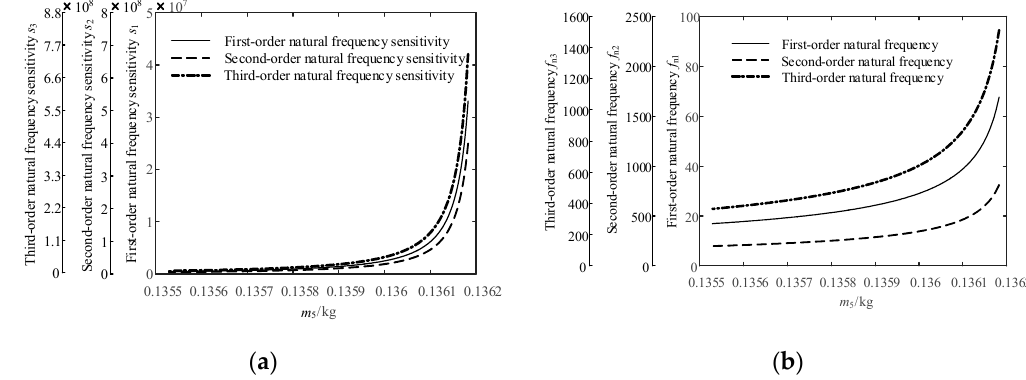
Figure 10. The variation law of the first three natural frequencies and their sensitivities of the jet system under a different initial gas content of fluid with the mass of fluid unit 2. ( a ) Variation law of natural frequency sensitivity. ( b ) Variation law of natural frequency.